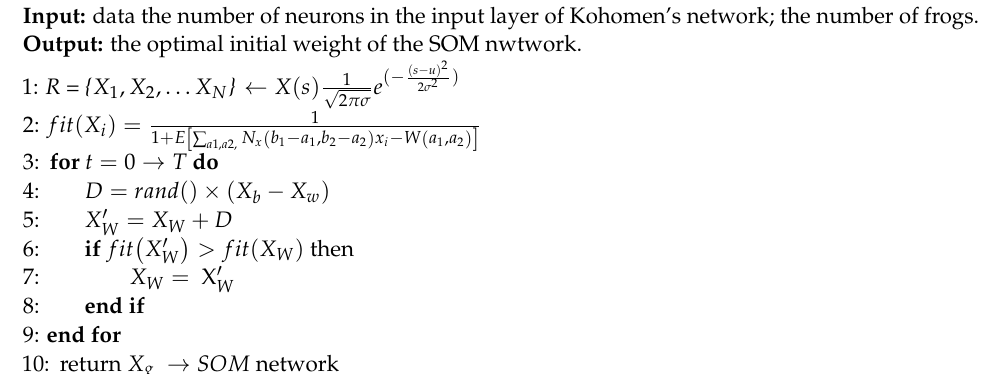
Algorithm 2 SFLA optimizes the initial weight of Kohomen